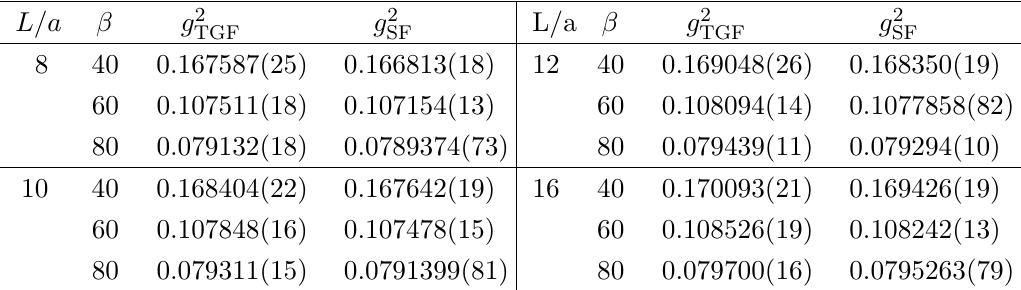
Table 8 . TGF and SF couplings on each lattice and each (cid:12) in the weak coupling region.